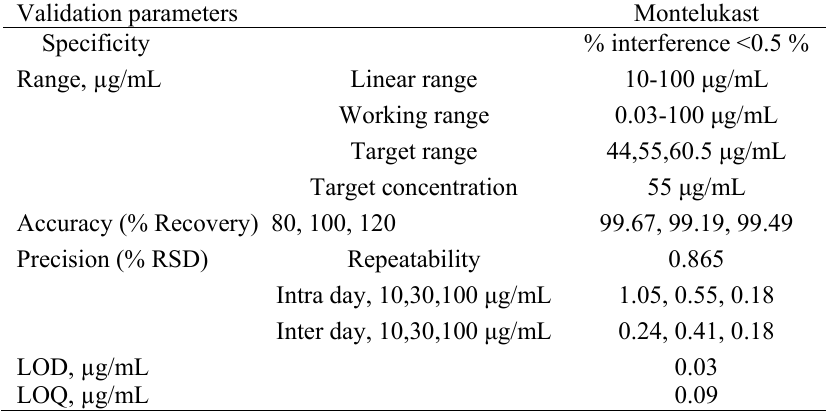
Table 3. Summary of validation parameters By RP-HPLC method